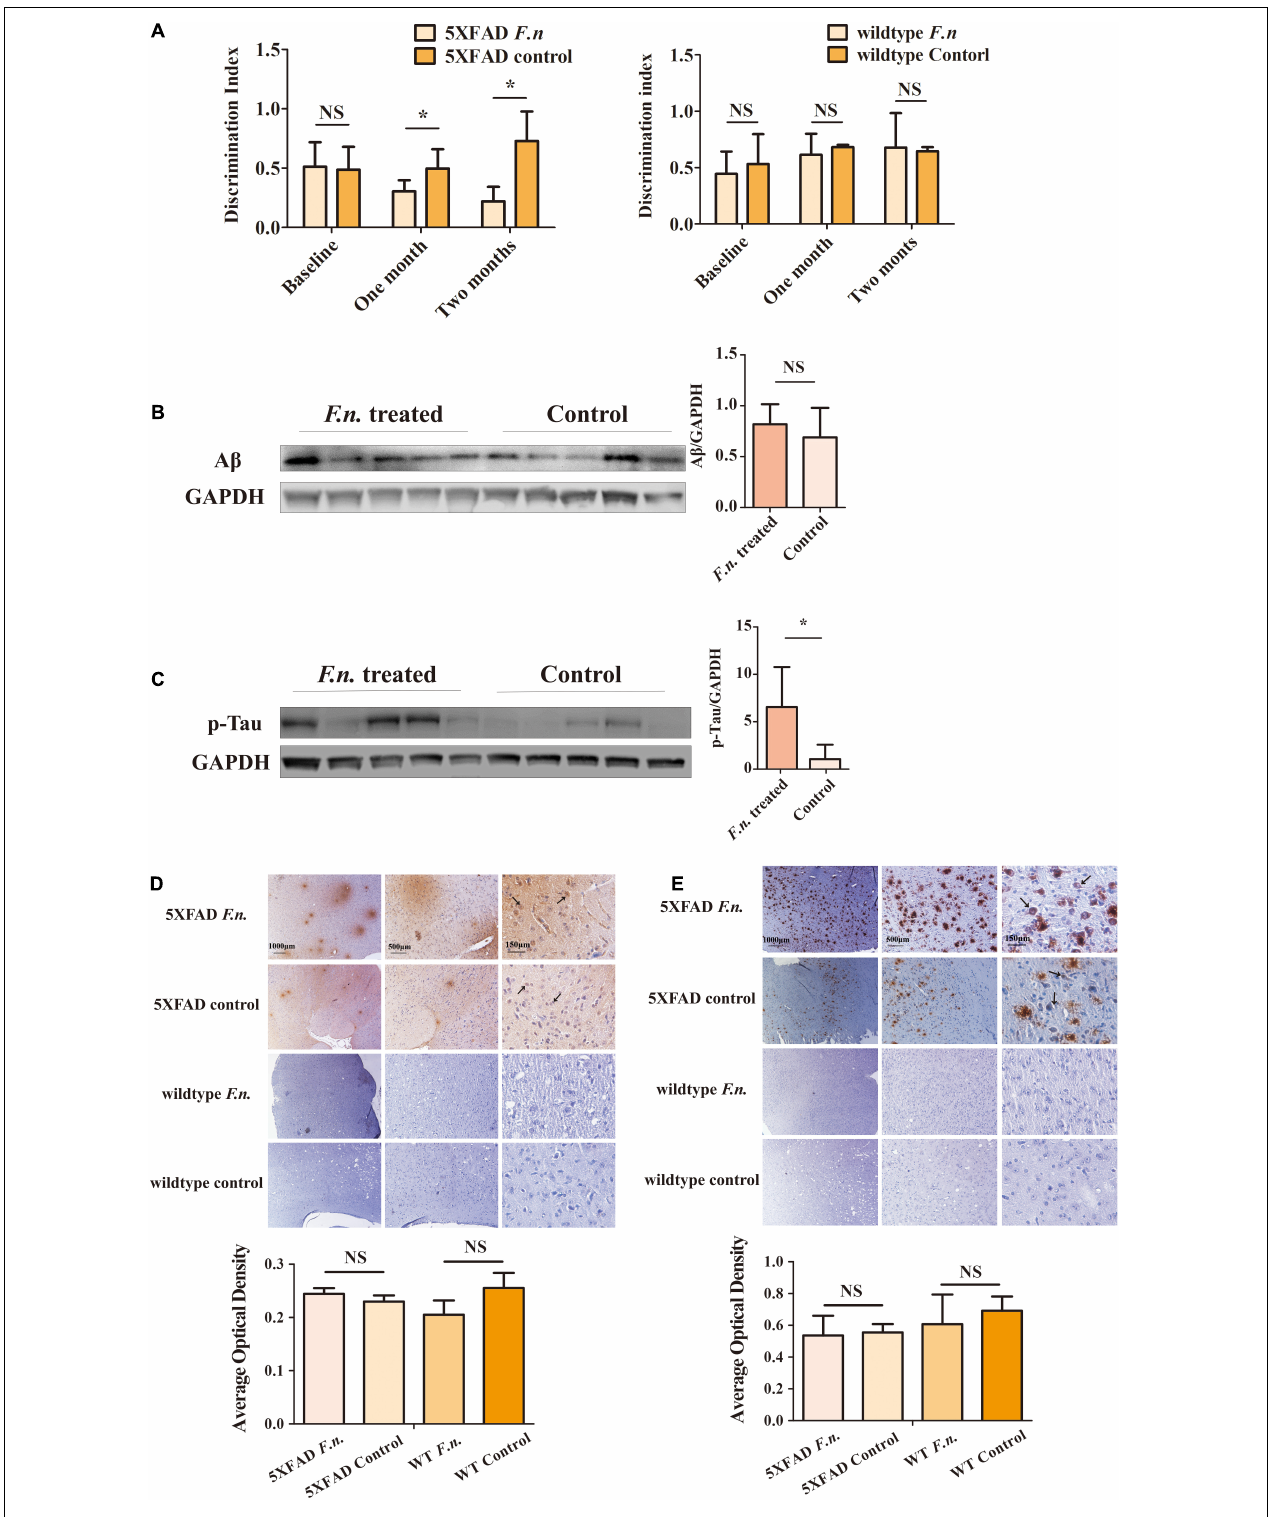
FIGURE 3 | The behavioral and pathological manifestation of 6-month-old 5XFAD mice and 6-month-old wild-type mice with or without F. nucleatum infection. (A) Results of novel object recognition (NOR) test of mice at baseline, one month and two months after infection. (B,C) The expression levels of (B) A β and (C) Tau protein in mice brain after two months of infection with F. nucleatum . (D,E) The distribution of (D) A β and (E) Tau protein in mice cerebrum cortex after two months of infection. All data were expressed as mean ± SD, n = 5, *P < 0.05 vs. the control group. NA, not significantly different.